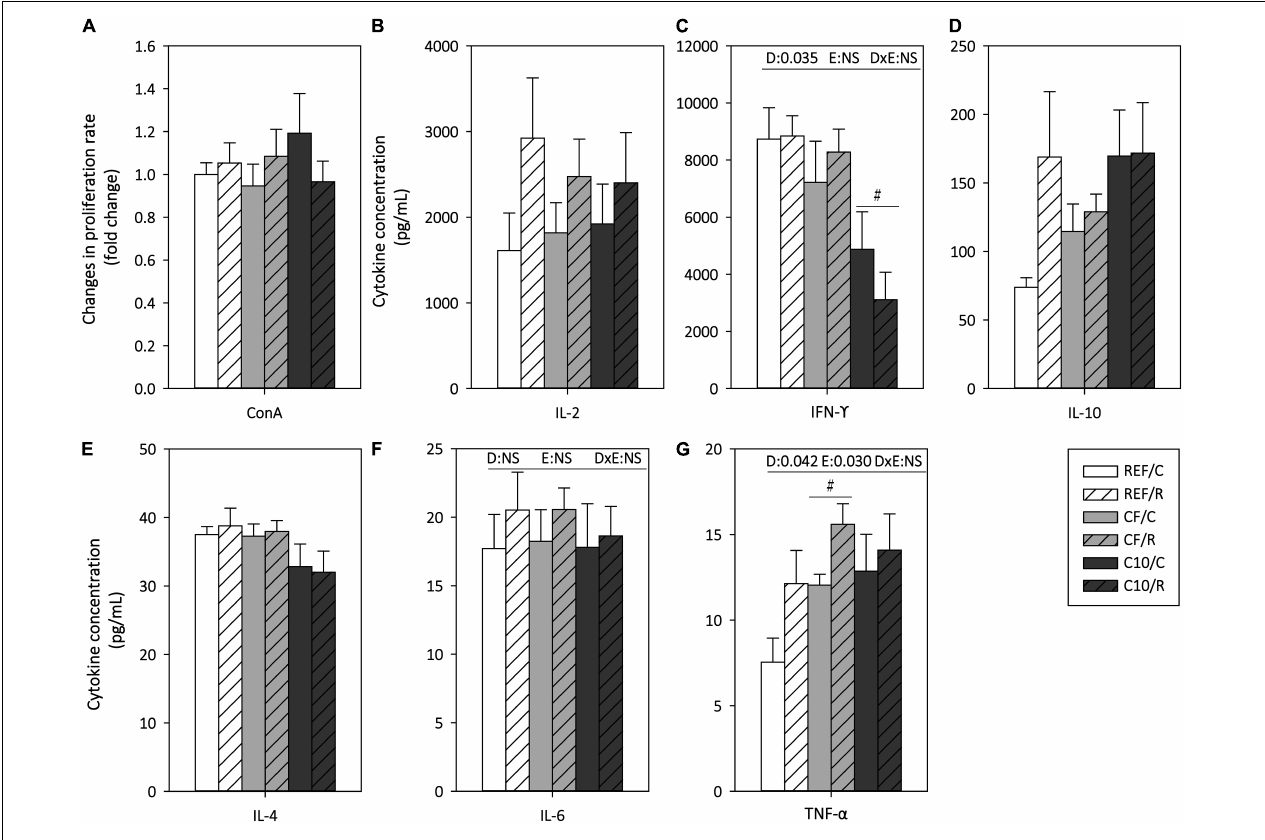
FIGURE 8 | Mesenteric lymph node lymphocyte functionality: proliferation response (A) and cytokine concentration released under concanavalin A (Con A) stimulation (B–G) . The control (C) groups are represented by smooth bars and the runner (R) groups by striped bars. REF, reference diet; CF, 5% cocoa fiber-enriched diet; C10, 10% cocoa-enriched diet; NS, no statistically significant differences detected. Data are expressed as mean ± SEM ( n = 8). Statistical differences (two-way ANOVA followed by post hoc Tukey for (C,F,G) and Kruskal-Wallis followed by Dunnet’s test for (A,B,D,E) : # p < 0.05 vs. the same exercise condition in the REF diet. The inset table shows two-way ANOVA results when applied (D, diet; E, exercise, DxE, interaction between diet and